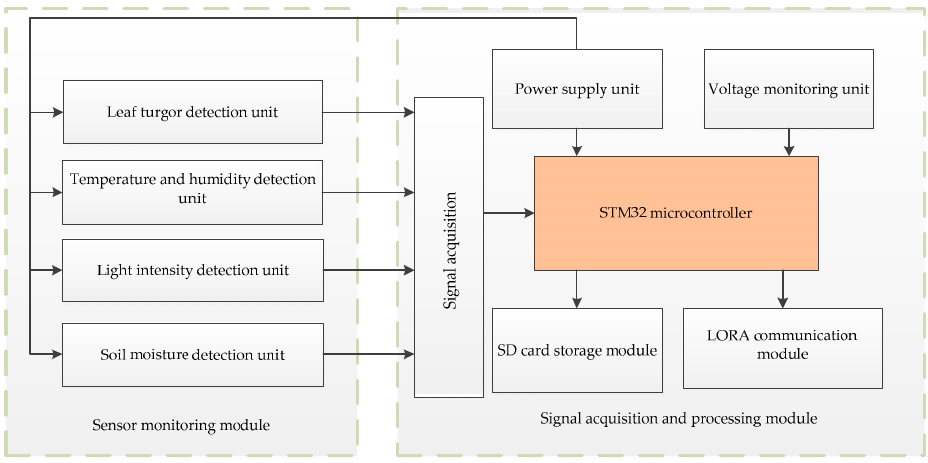
Figure 3. System architecture diagram.